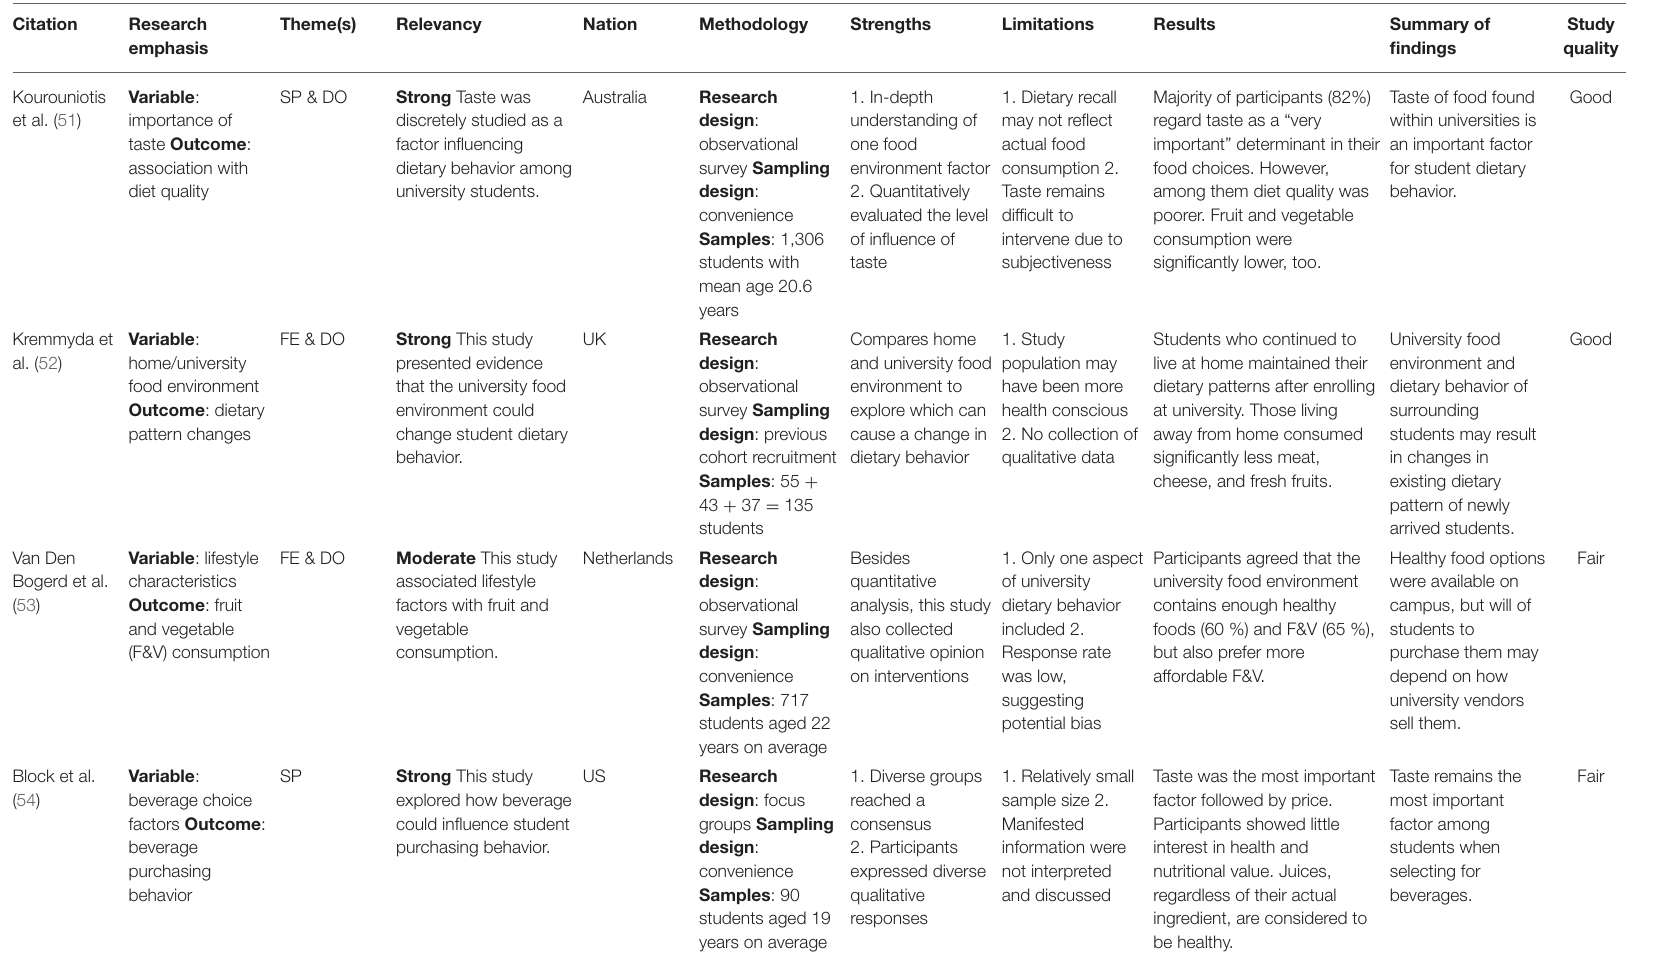
TABLE 3 | Summary of included studies and the methods used.